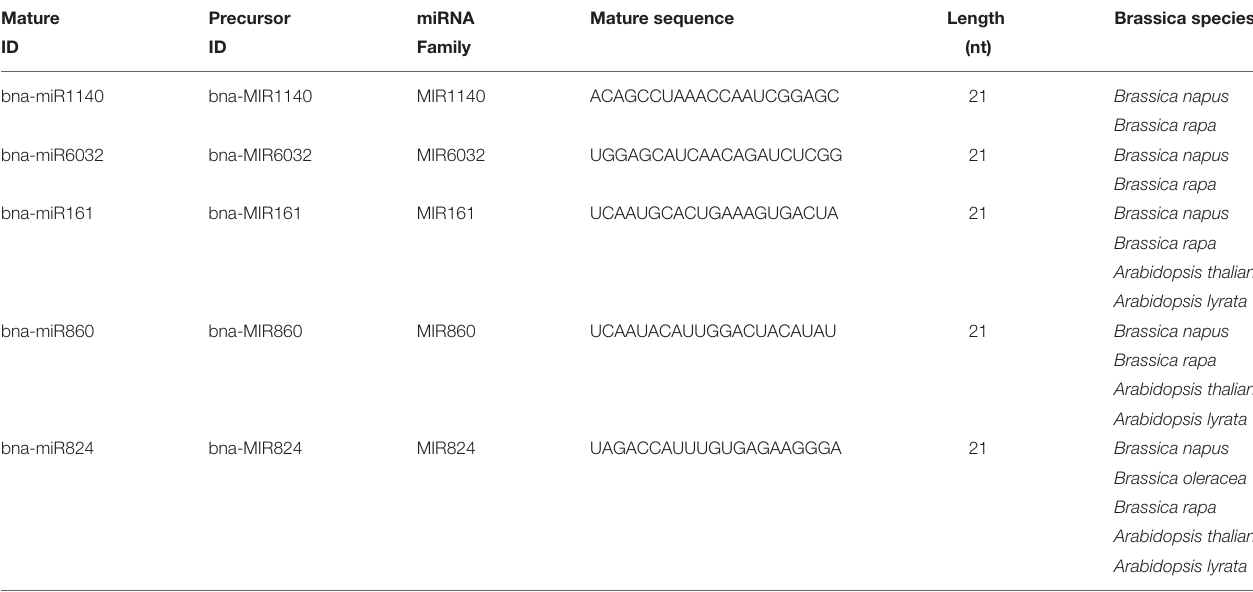
TABLE 2 | Five micro ribonucleic acids (miRNAs) belonging to miRNA families specific for Brassica . Mature